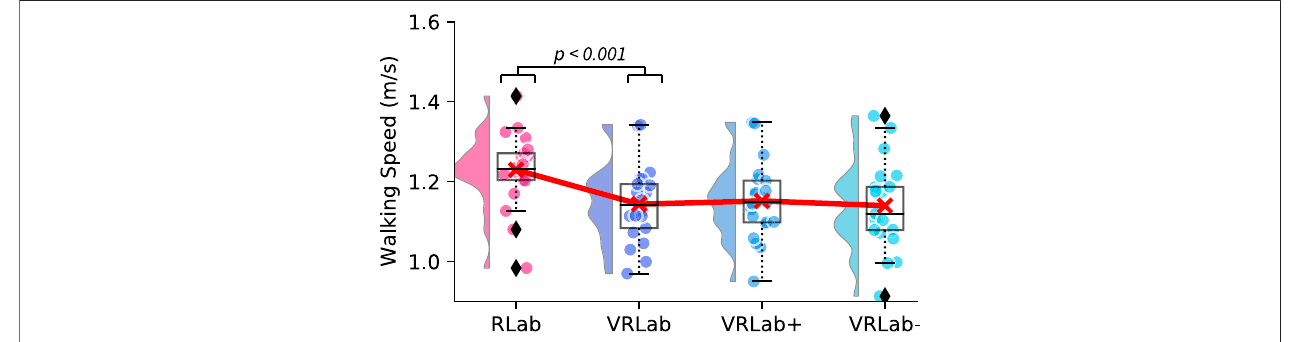
FIGURE3 | Walkingspeed during walking in thereal lab (RLab), thevirtual lab (VRLab), the over-sized (VRlab+), and down-sized (VRLab − ) lab. The plot shows the data distribution (probability density function), the jittered raw data, the mean (red line), and a box plot showing quartiles where whiskers extend to the end of the data distribution except for outliers (diamonds) Allen et al. (2021).